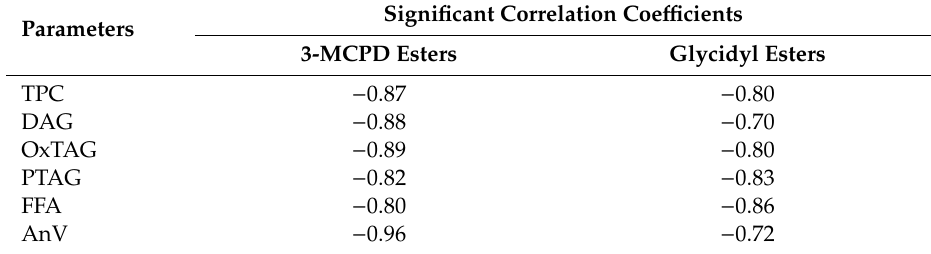
Table 4. Significant correlation coe ffi cients between quality parameters and 3-MCPD esters and glycidyl esters